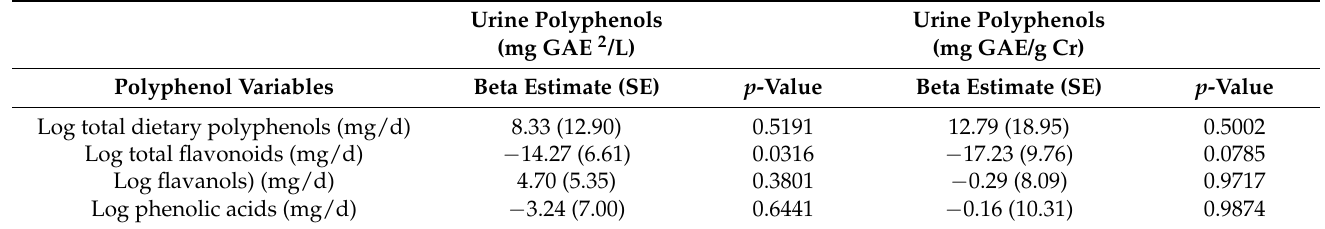
Table 6. Association between the spot urine polyphenol excretion at year 2 and the dietary intake of polyphenols and subclasses 1